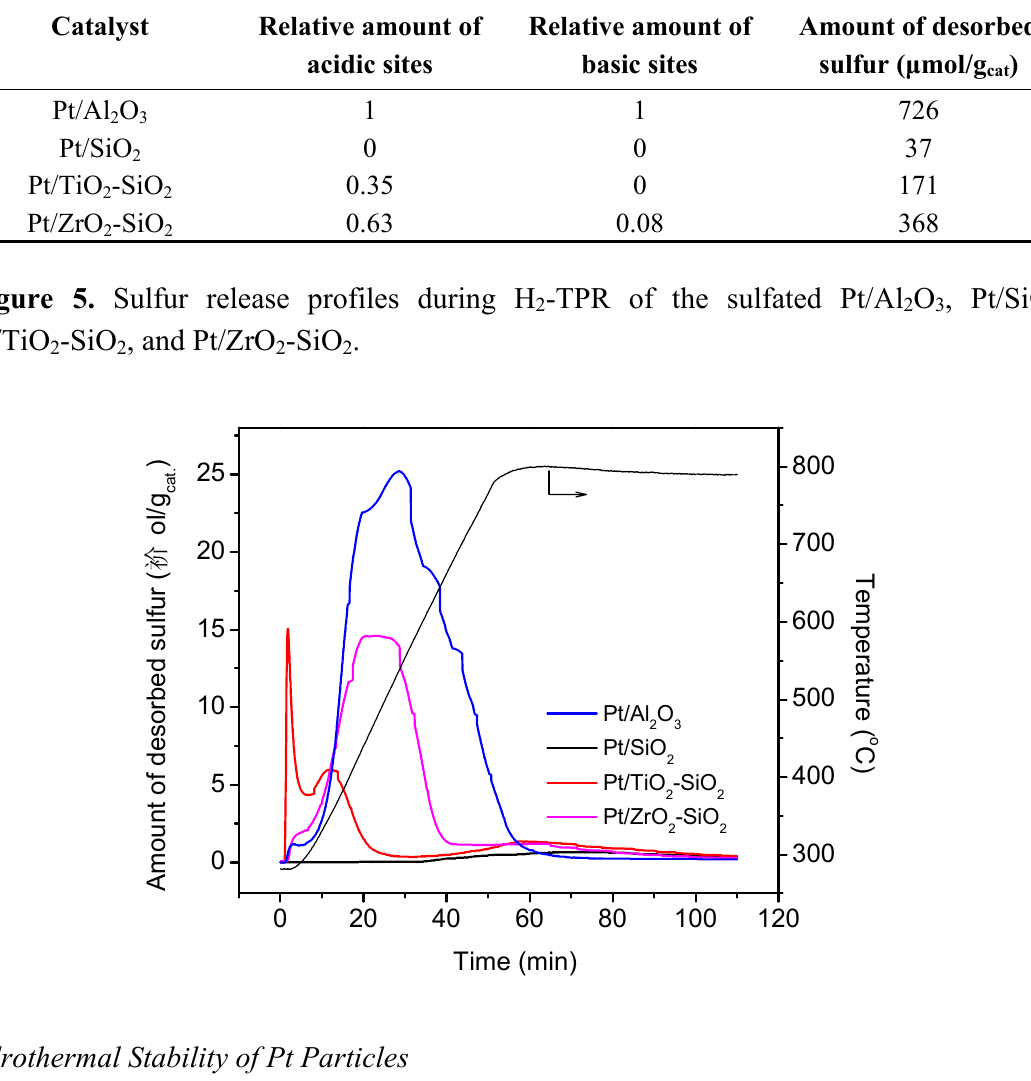
-TPR of the sulfated Pt/Al 2